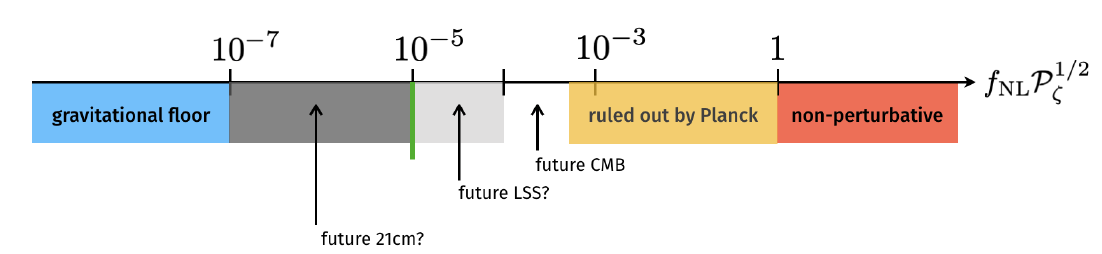
Figure 2. A schematic representation of current and future limits on the primordial non-Gaussianity amplitude parametrized by f NL . Credits to